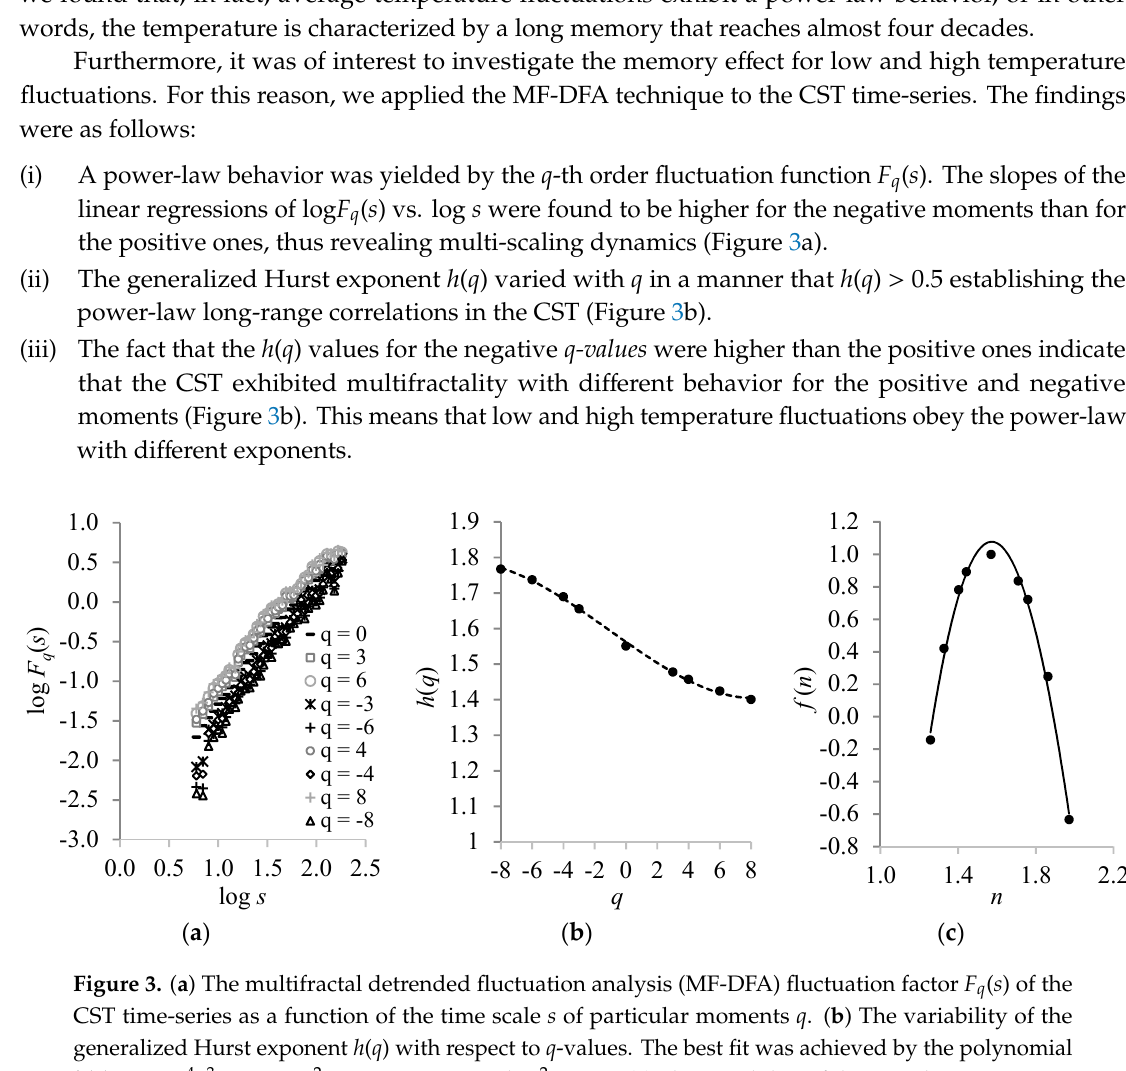
Figure 3. ( a ) The multifractal detrended fluctuation analysis (MF-DFA) fluctuation factor F q ( s ) of the CST time-series as a function of the time scale s of particular moments q . ( b ) The variability of the generalized Hurst exponent h ( q ) with respect to q -values . The best fit was achieved by the polynomial h(q) = 1 · 10 − 4 q 3 + 0.0004 q 2 − 0.03 q + 1.56, with R 2 = 1.00. ( c ) The variability of the singularity spectrum f ( n ) versus singularity strength n , with a best fit expressed by the equation: f(n) = 1.74 n 3 − 19.48 n 2 + 48.35 n − 33.57, with R 2 =